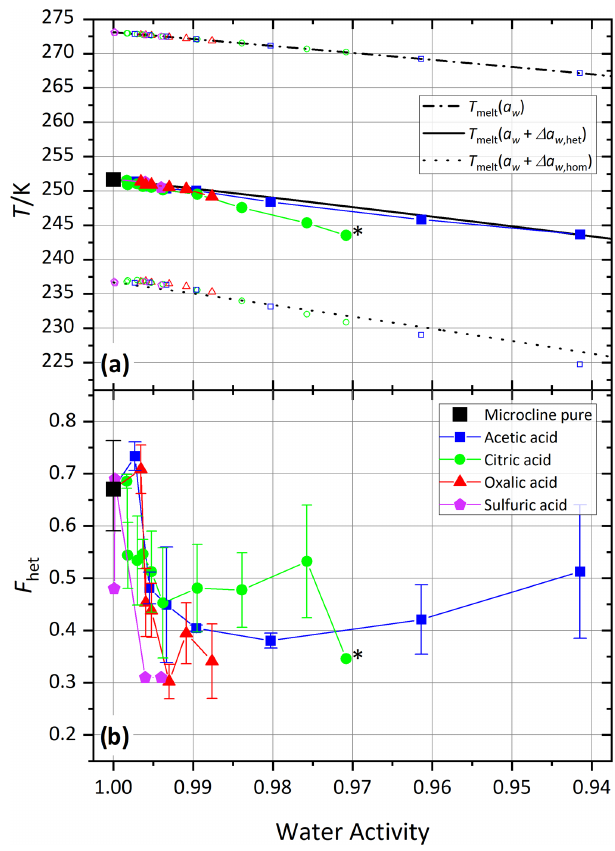
Figure 3. Freezing experiments with microcline (2wt%) in aque- ous carboxylic acid solutions as a function of water activity. For comparison, microcline 2wt% in sulfuric acid data from Kumar et al. (2018) are shown as magenta pentagons. (a) Melting tem- peratures, T melt (open symbols between 265 and 275K), hetero- geneous freezing onset temperatures (filled symbols), and homo- geneous freezing onset temperatures (open symbols between 220 and 240K) as a function of water activity, a w . Dash-dotted black line: ice melting point curve; solid black line: heterogeneous freez- ing curve, T het ( a w ); dotted black line: homogeneous freezing curve, T hom ( a w ). All points are the average of at least two separate emul- sion freezing experiments. Measurements without a repetition are marked with a black star label (see the Supplement for individual DSC curves). (b) Heterogeneously frozen fraction, F het , as a func- tion of water activity, a w . Measurement uncertainties in F het are shown as the spread from minimum to maximum measured values for all F het values from this study measured with a